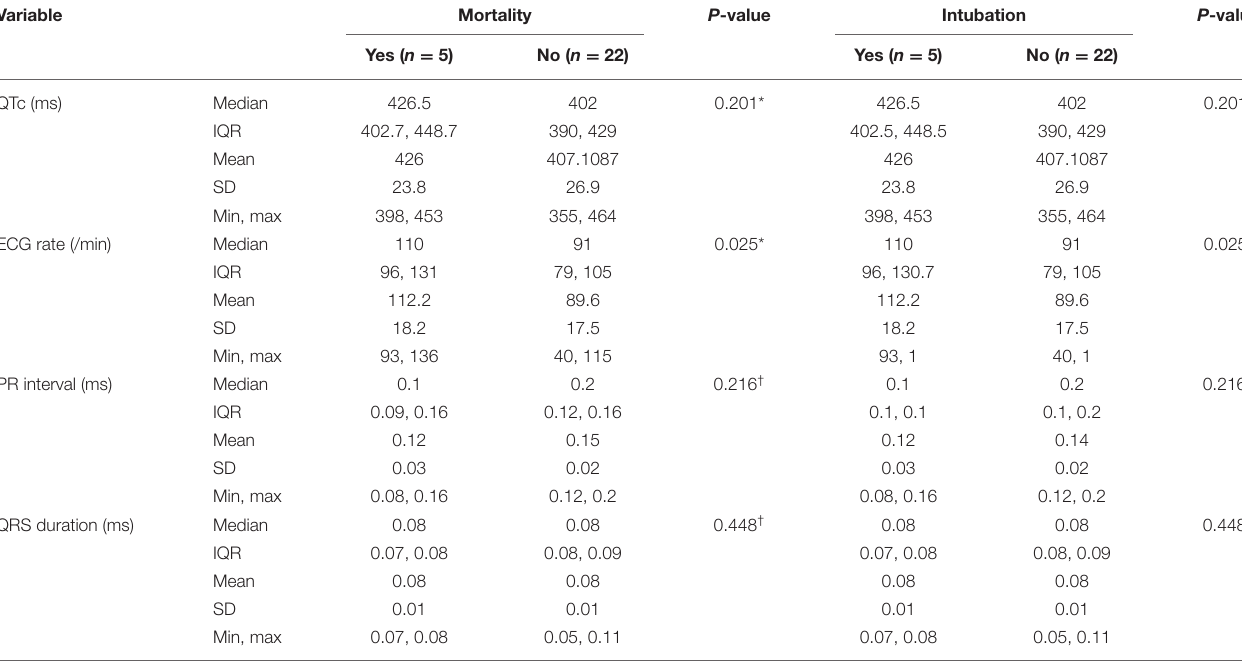
TABLE 6 | Quantitative ECG findings in mortality and intubation